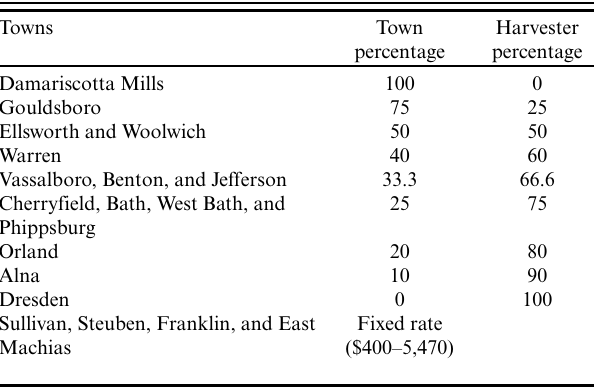
Table 1. The variety of ways that municipalities split the revenue gained by the alewife ( Alosa pseudoharengus ) harvest between the town and the